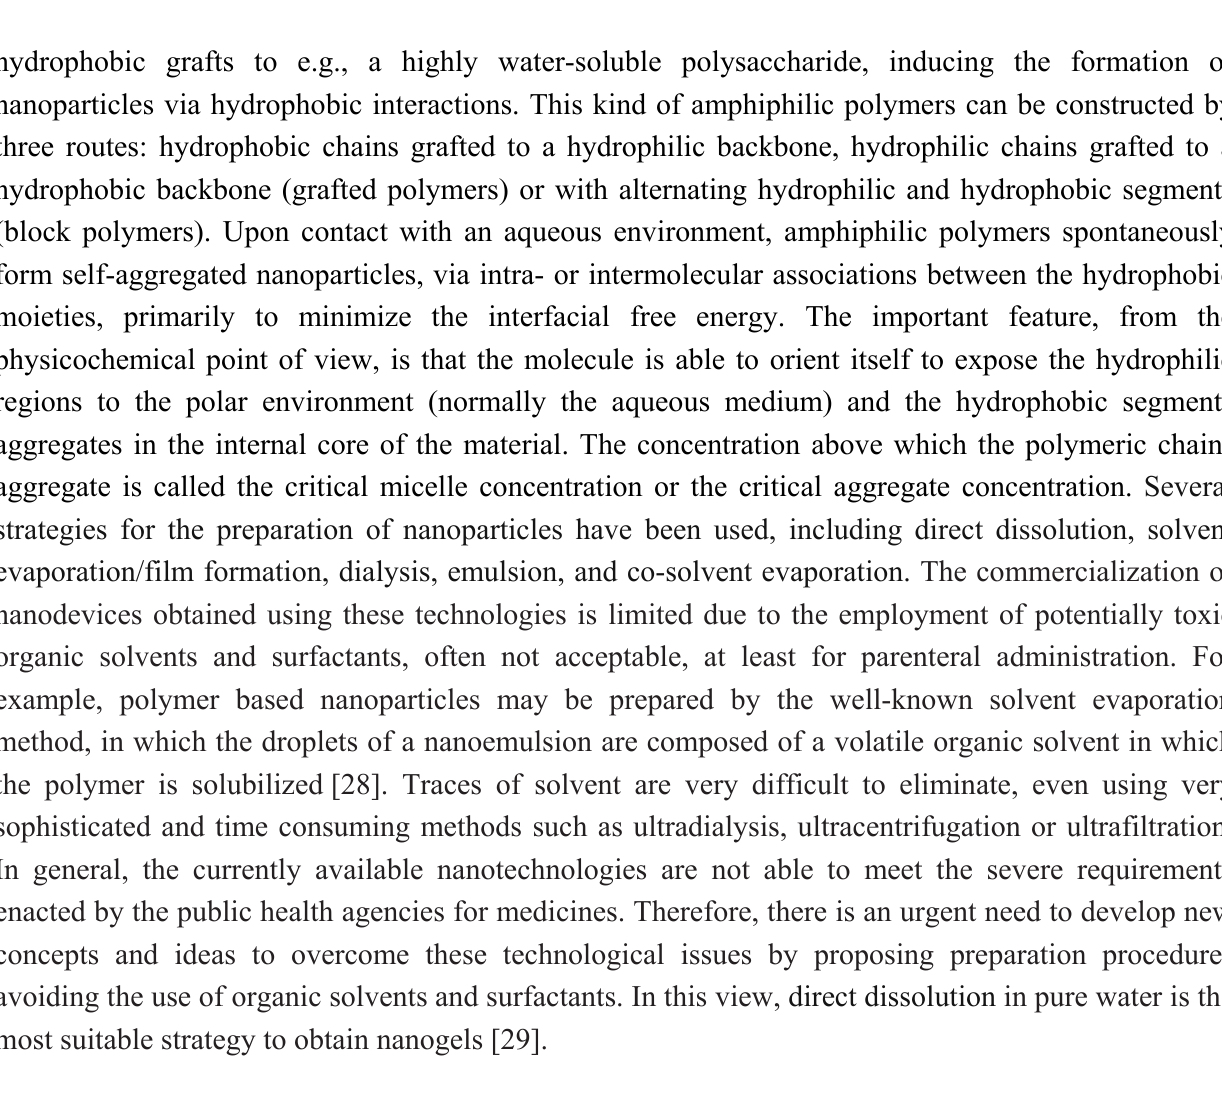
Figure 3. Schematic representation of intermolecular interactions driving self-assembly processes that includes (a) electrostatic interactions and (b) hydrophobic